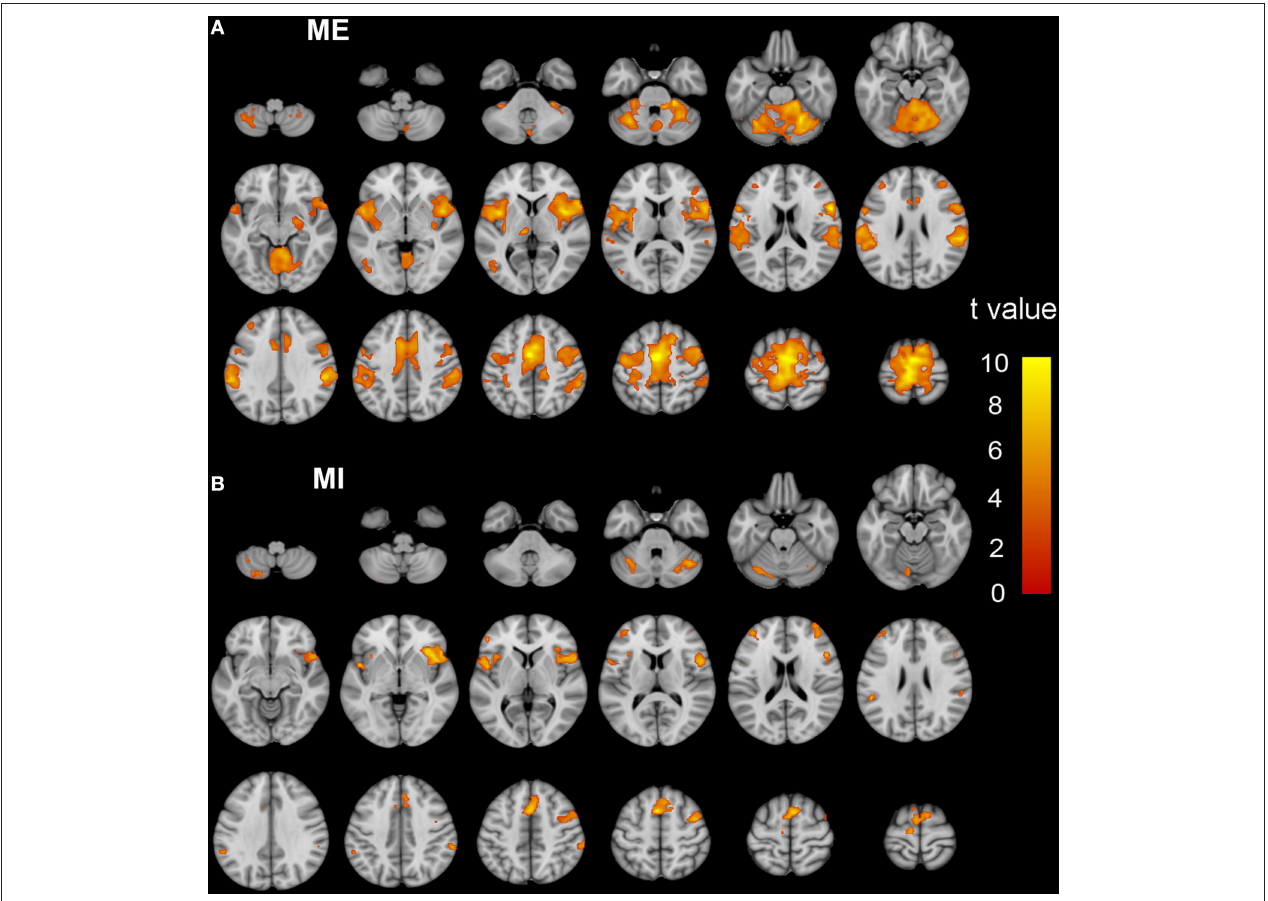
FIGURE 3 | The activation patterns of the ME and MI tasks in ISCI patients. Typical brain regions with activation during the ME task are shown in (A) , while brain regions with activation during an MI task are shown in (B) . Significant activation was considered when the voxel-wise threshold was q < 0.01 (FDR correction) and the cluster ≥ 30 voxels. The right side of the image corresponds to the right hemisphere. The color bar represents the t -values. ME, motor execution; MI, motor imagery; ISCI, incomplete spinal cord